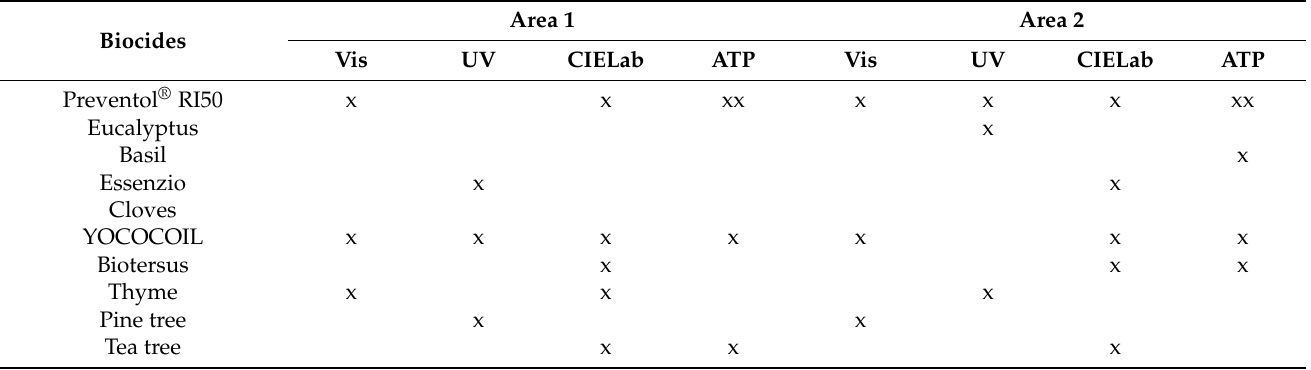
Table 7. Best results for each analysis of the tested products for Area 1 and 2.